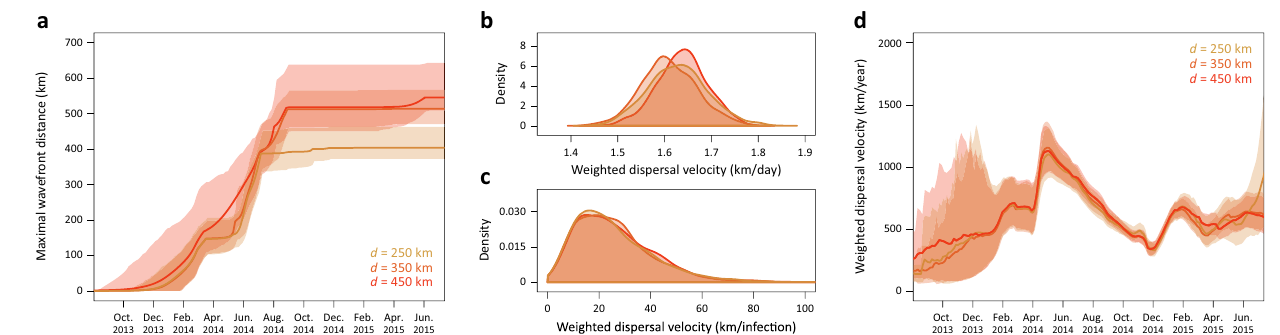
Fig. 3 Dispersal statistics summarised from continuous phylogeographic inference. Evolution of maximal wavefront distance ( a ), mean dispersal velocity ( b , c ) and dispersal velocity through time ( d ) for each data set ( d = 250, 350 and 450 km). These statistics were summarised from 1000 trees sampled from the posterior distribution of trees. Weighted dispersal velocities are reported in both km per day ( b ) and in km per infection ( c ). Weighted dispersal velocities in km per infection are obtained by multiplying mean branch velocities (in km/day) by serial interval values (in days between successive infections) randomly drawn from the generation time distribution estimated by the WHO Ebola Response